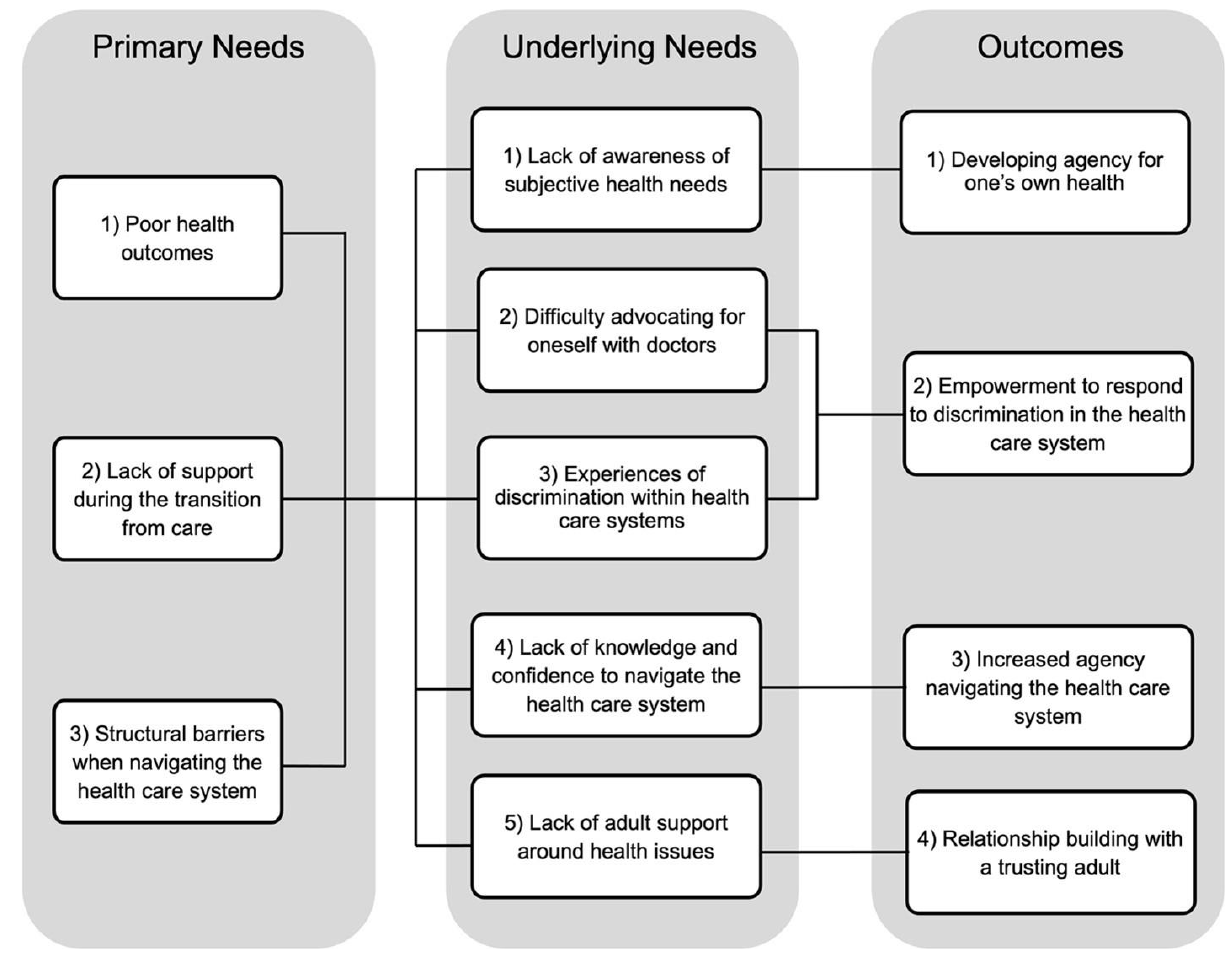
Figure 1. Summary of Primary Needs, Underlying Needs, and Program